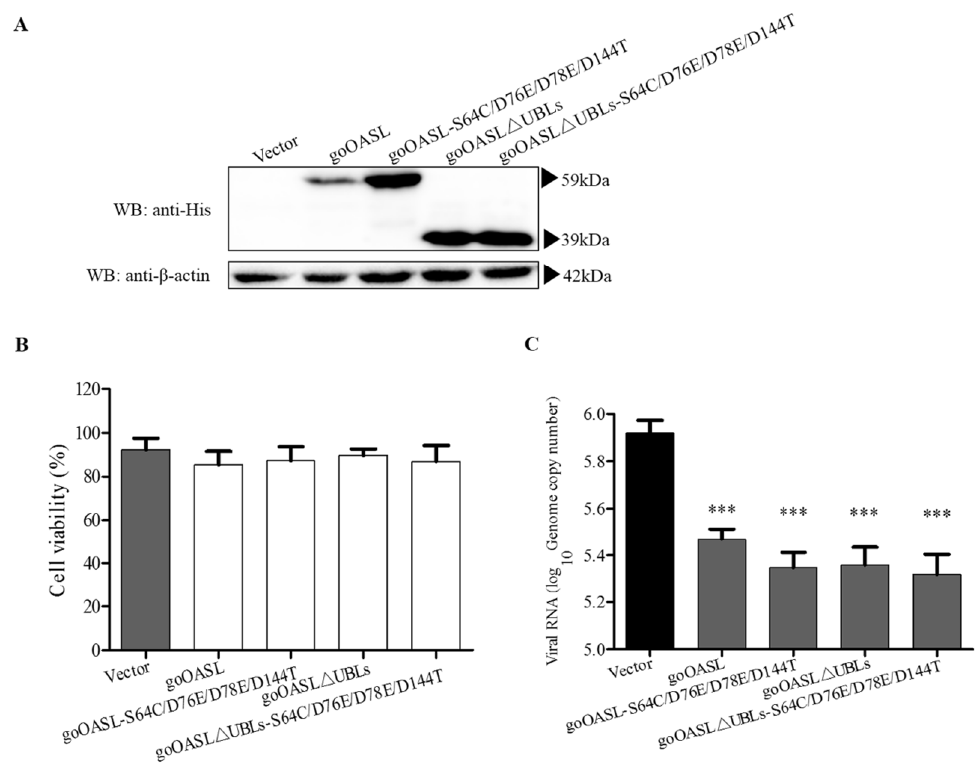
Figure 3. The antiviral activity of goOASL and goOASL-mutant proteins against DTMUV in DEFs. ( A ) Overexpression of goOASL-mutant proteins in DEFs. DEFs seeded in a 12-well plate were transfected with pcDNA3.1 (+) vector, goOASL, goOASL-S64C/D76E/D78E/D144T, goOASL ∆ UBLs and goOASL ∆ UBLs-S64C/D76E/D78E/D144T (1.6 µ g/well), respectively. At 24 h after transfection, the cells were harvested using RIPA buffer for western blotting analysis. Mouse monoclonal anti-His antibody or mouse monoclonal anti- β -actin antibody was used as the primary antibody, HRP-goat anti-mouse IgG was used as the secondary antibody; ( B ) Detection of the cytotoxicity of goOASL and its mutant proteins in DEFs. The optical density (OD) value of all samples was measured at 450 nm after the goOASL-, goOASL-S64C/D76E/D78E/D144T-, goOASL ∆ UBLs- and goOASL ∆ UBLs-S64C/D76E/D78E/D144T-overexpressed cells and control cells were treated with CCK-8 reagent for 3 h. Cell viability was calculated using the standard formula; ( C ) GoOASL-mutant proteins exhibited antiviral activity against DTMUV in DEFs. At 24 h after transfection, the goOASL-, goOASL-S64C/D76E/D78E/D144T-, goOASL ∆ UBLs- and goOASL ∆ UBLs-S64C/D76E/D78E/D144T-overexpressed cells and control cells were infected with DTMUV at 24 h after transfection with the pcDNA3.1 (+) vector (10 4 TCID 50 /well). At 24 h, the genome copy number of DTMUV in the cells was quantified via qRT-PCR. All data were analysed using GraphPad Prism software and were represented as the means ± SD ( n = 3). Significance was determined via the unpaired two-tailed t -test (*** p < 0.001).